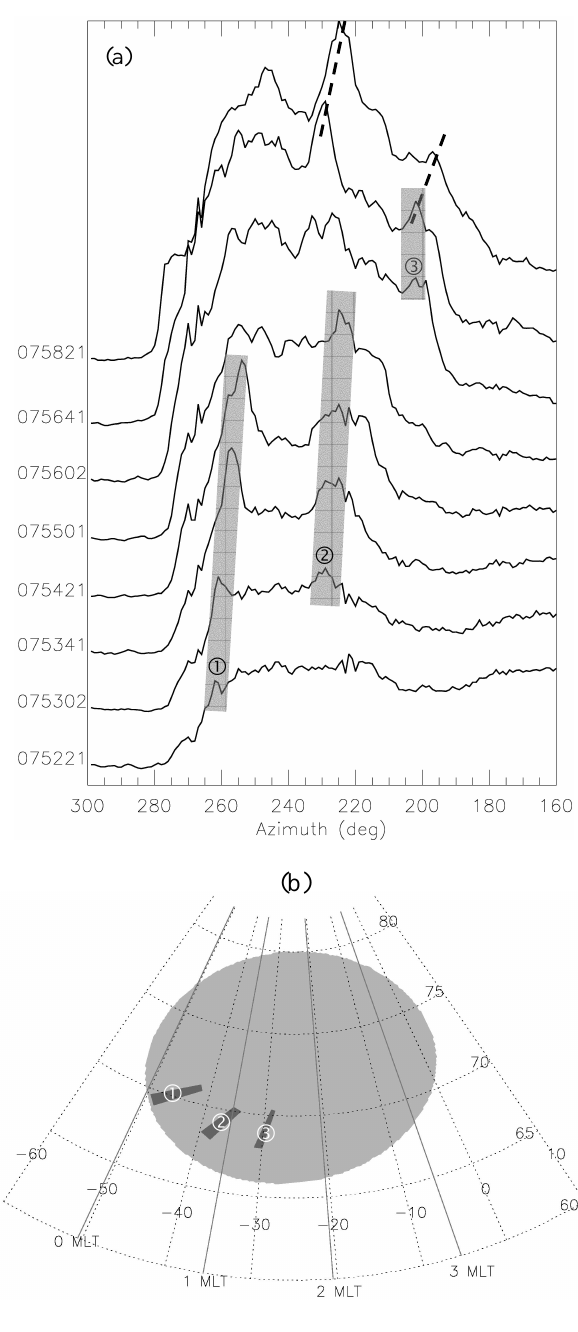
Figure 10 Same as Figure 8, but for the substorm EP interval.